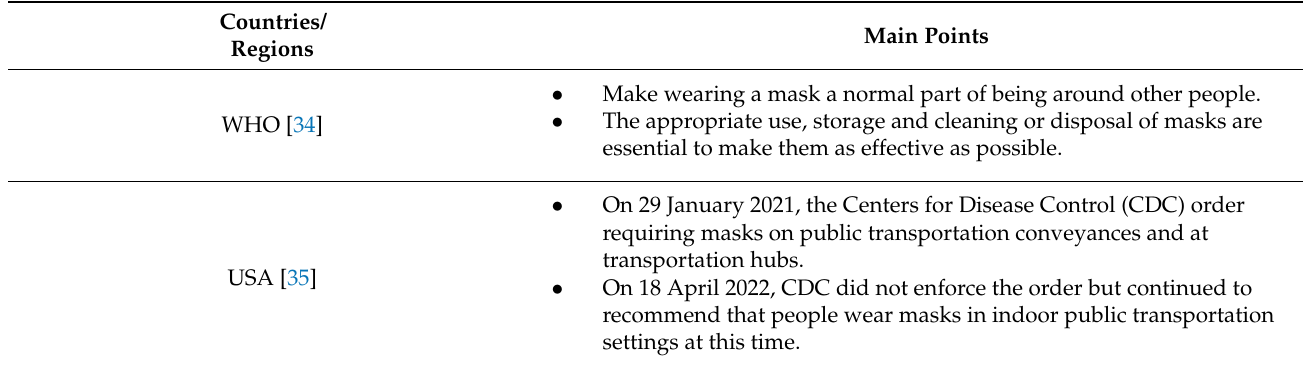
Table 1. Mask use recommendations by different health